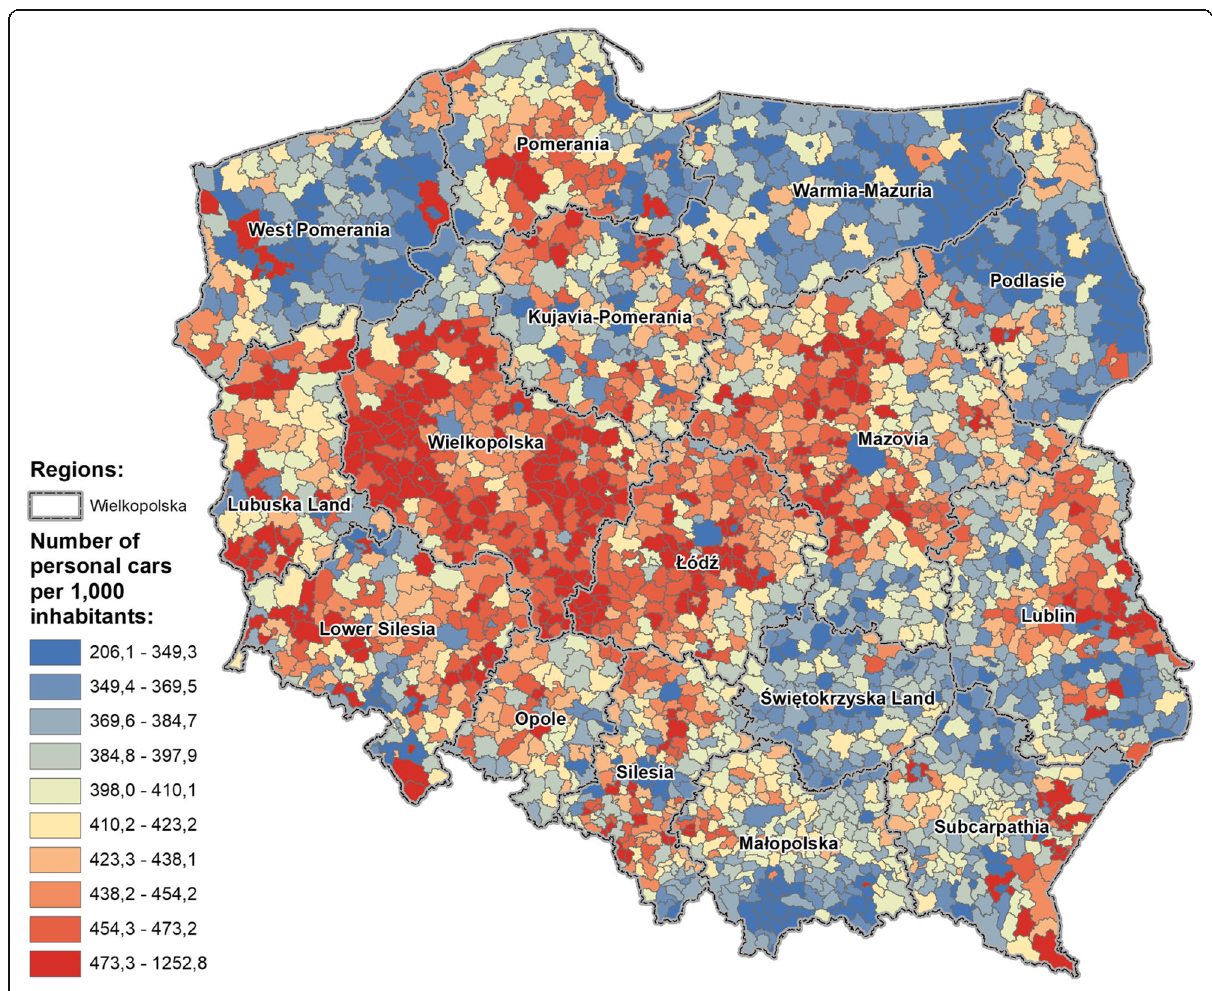
Fig. 3 Spatial structure of car ownership in Poland. Source: own elaboration based on the Central Vehicle Agency